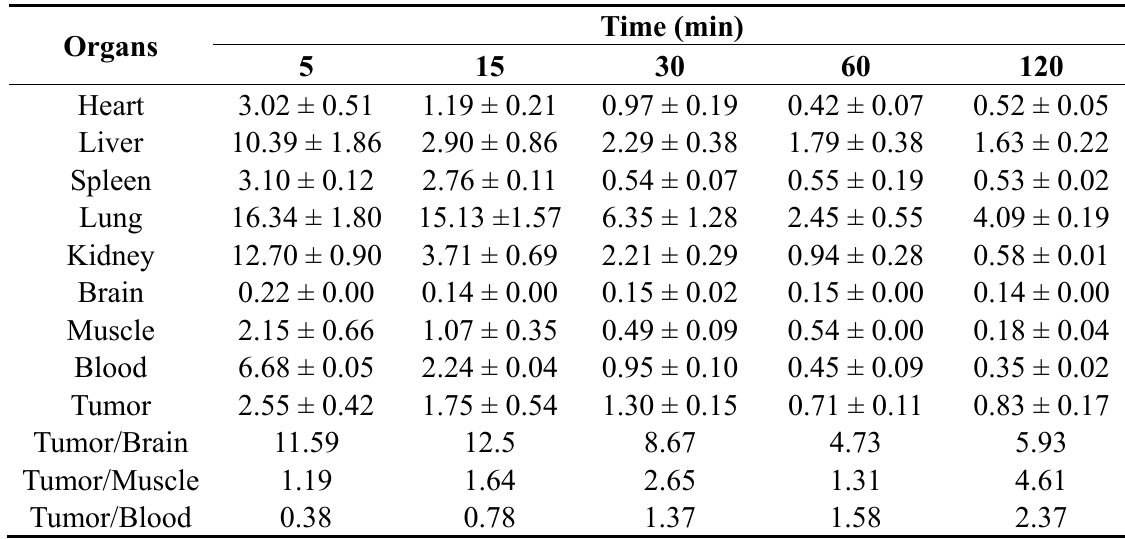
Table 3. Biodistribution of [ 18 F] 5 in mice bearing S 180 tumor. Expressed as % injected dose per gram (% ID/g ± SD), n =